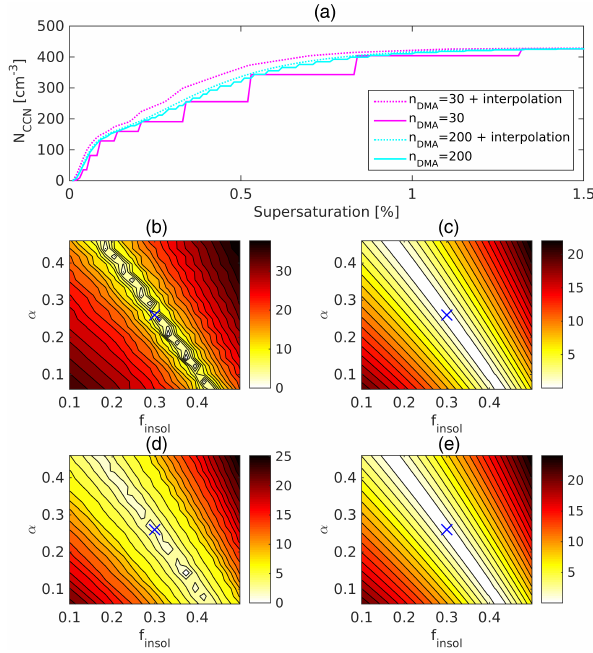
Figure 12. (a) Calibration data for the marine average environment derived from aerosol size distributions of 30 and 200 sizes bins, both with and without intra-bin interpolation. The corresponding OF response surface for (b) 30 bins and no interpolation; (c) 30 bins with interpolation; (d) 200 bins and no interpolation; (e) 200 bins with